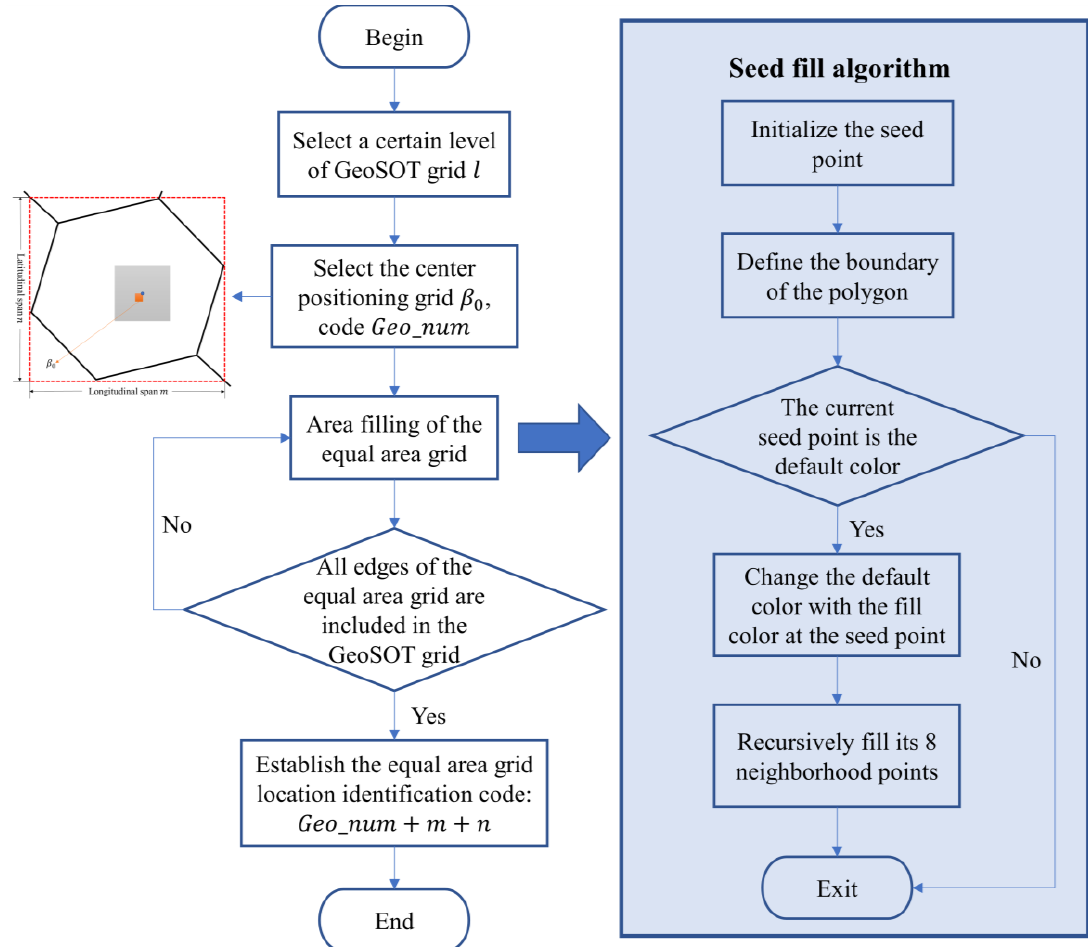
Figure 3. The procedure of fitting algorithm for the equal area gird.